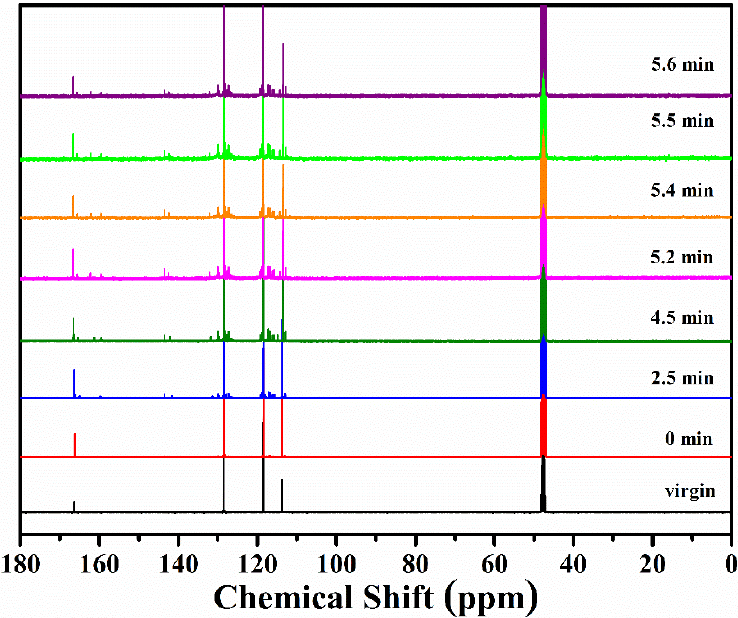
Figure 4. 13 C composite pulse decoupled (CPD) NMR spectra of sodium phenolates with time at 495 °C.